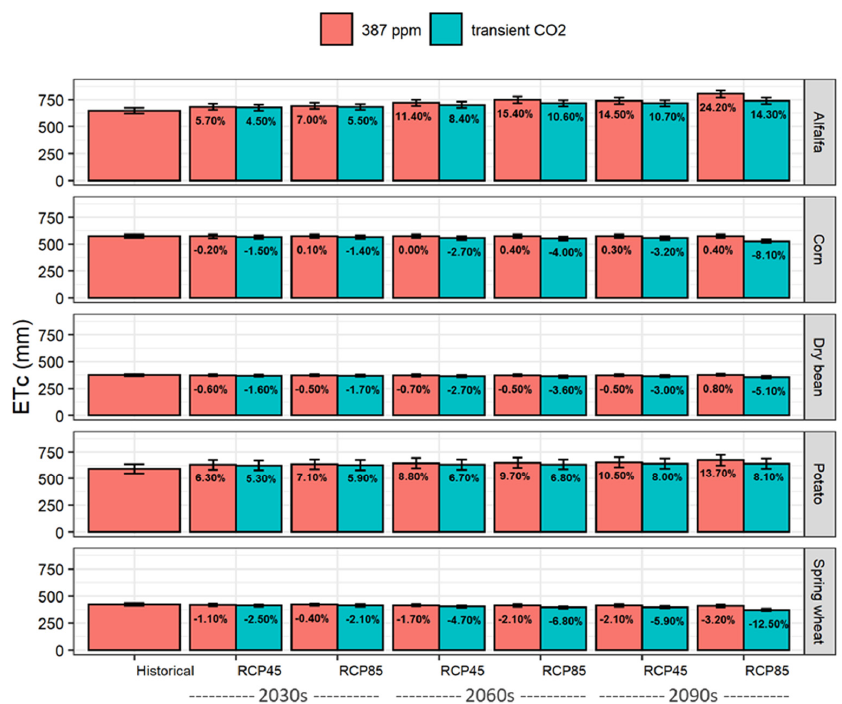
Figure 7. Comparison of future crop evapotranspiration (ETc) under transient CO 2 versus constant contemporary CO 2 (387 ppm). Results are for a fixed planting date. Percent numbers correspond to ETc change relative to historical values.